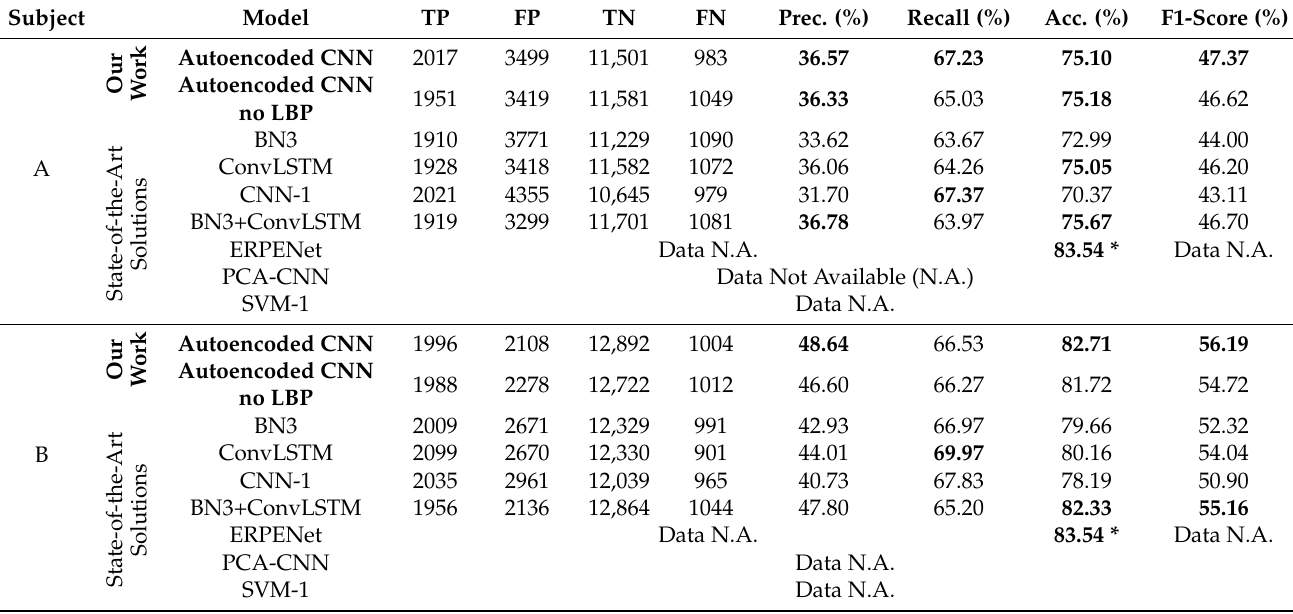
Table 4. Performance of different models on test dataset from Dataset